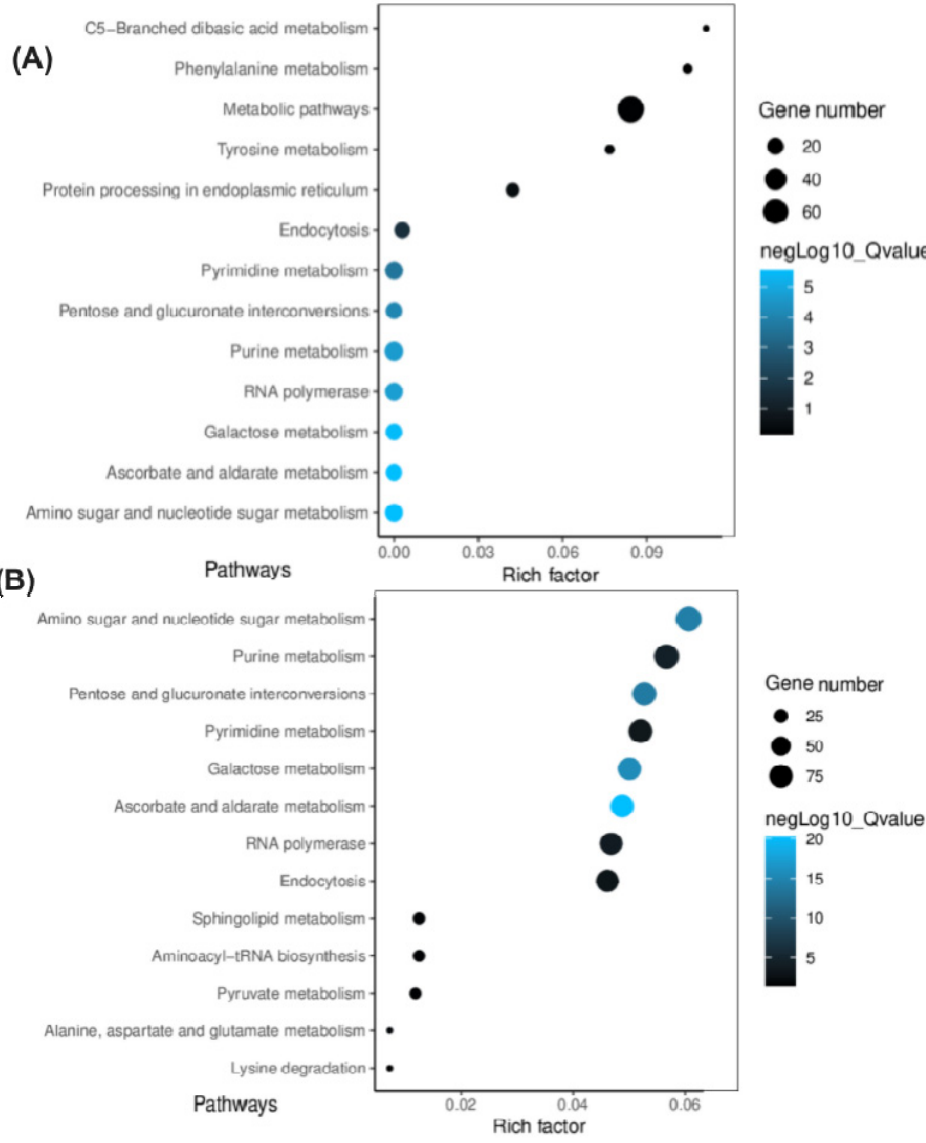
Figure 7. KEGG analysis for target genes of differently expressed miRNAs in response to salinity stress in the roots of Suntop ( A ) and Sunmate ( B ). The Y axis identifies the KEGG pathway, the X axis shows the enrichment ratio between the number of DEGs and all genes enriched in a particular pathway. The color of the dot represents the q-value, and the size of the dot represents the number of DEGs mapped to the referent pathway.